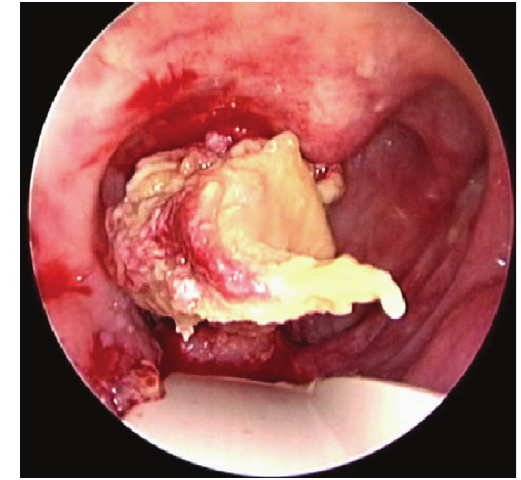
Figure 2: Endoscopic view of the right lateral oropharyngeal lesion.